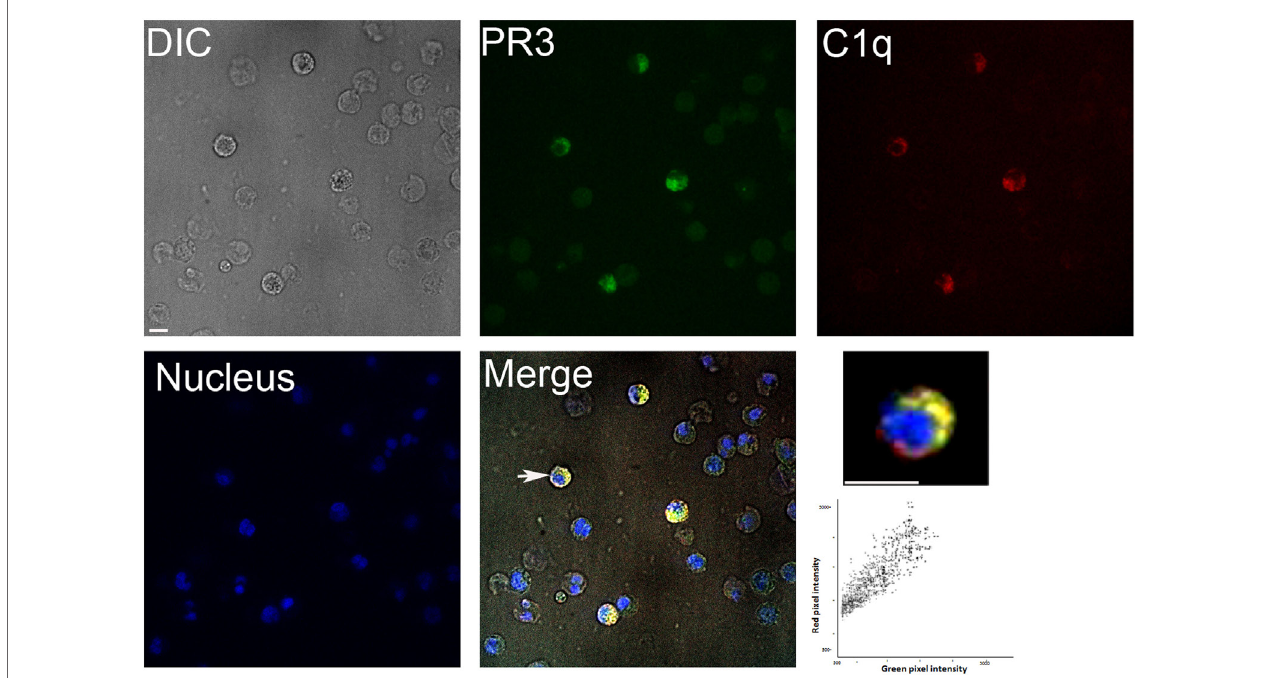
FigUre 1 | Colocalization of proteinase 3 (PR3) and C1q in neutrophils. Apoptotic neutrophils (prepared as described in Section “Materials and Methods”) were double labeled for membrane PR3 expression and C1q binding using an anti-PR3 mAb followed by an Alexa488-conjugated anti-mouse IgG and then incubating cells with Alexa647-C1q. Nuclei were labeled with DAPI. Samples were visualized by confocal microscopy under differential interference contrast (DIC), DAPI, A488, and A647 filters, and merge is shown (as indicated). Higher magnification is shown for one selected cell indicated by a white arrow. Scatterplot of red and green pixel intensities collected from the focal plane of the cell shown is represented. Scale bar 8 µm. Colocalization (yellow regions in merge) was evaluated by Pearson’s correlation coefficient ≥